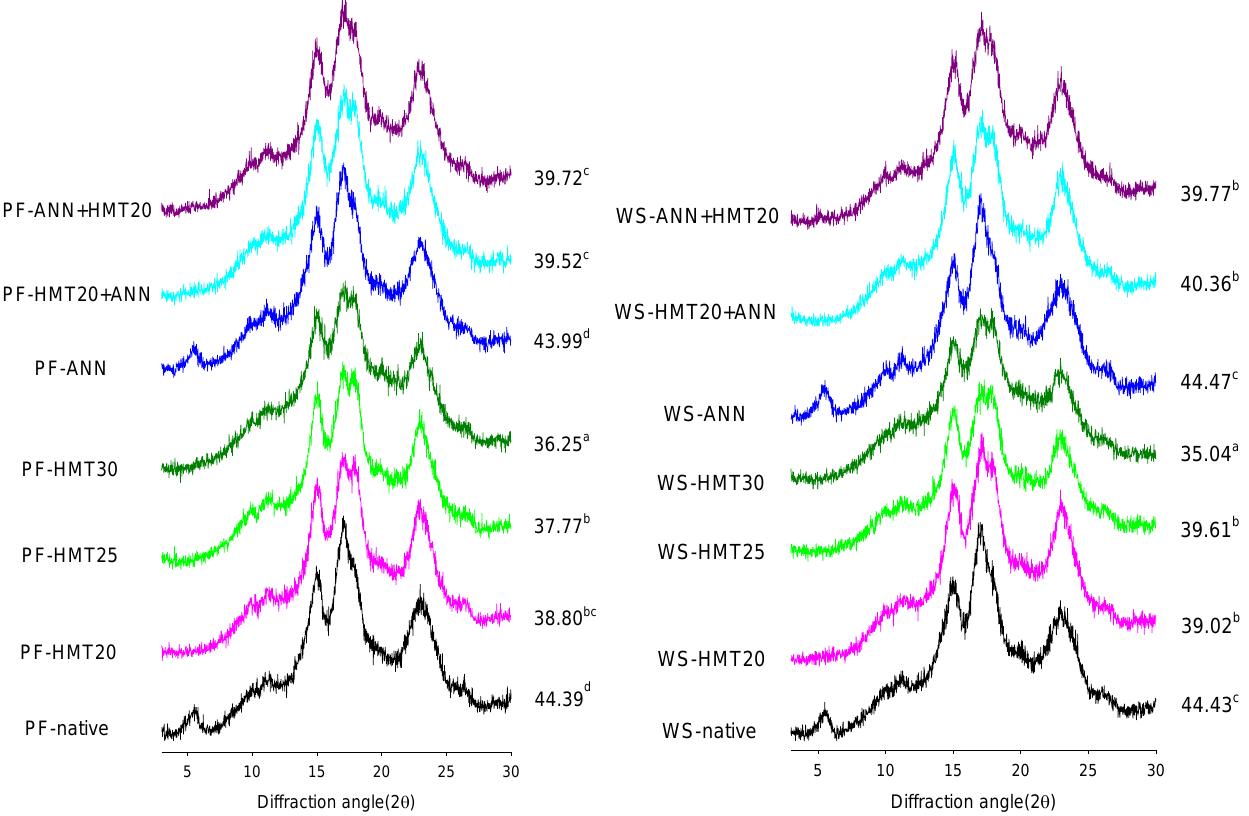
Figure 4. X-ray diffraction patterns and relative crystallinity of native and modified lotus rhizome starches. a–d Relative crystallinity values with different letter for the same variety are significantly different ( p < 0.05).